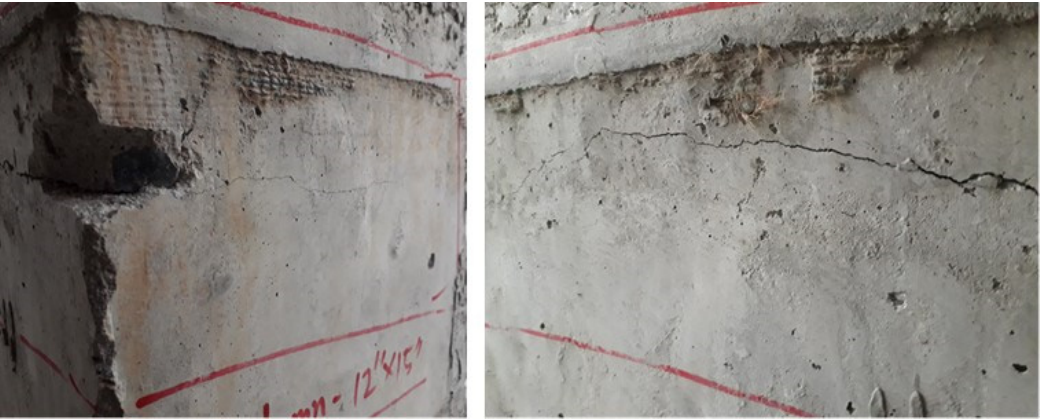
Figure 8. Cracking and spalling of concrete in a column due to overloading during the construction stage (used with permission from Khadem [23]).